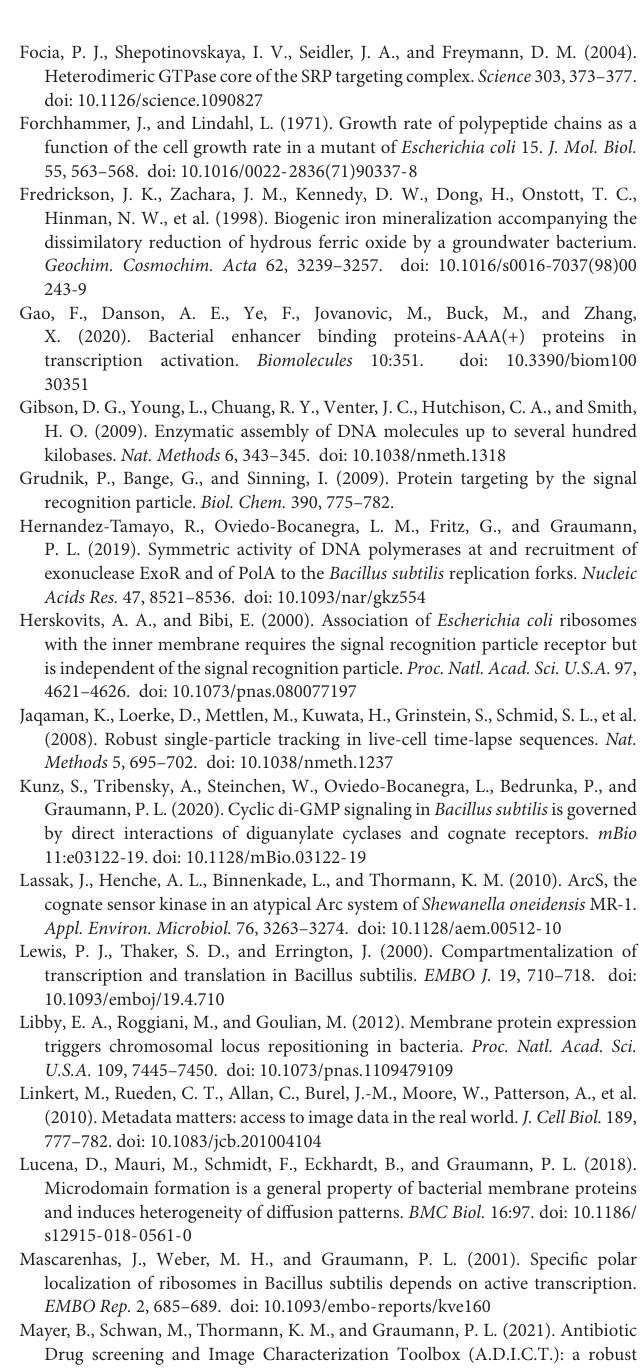
Supplementary Table 3 | Plasmids and